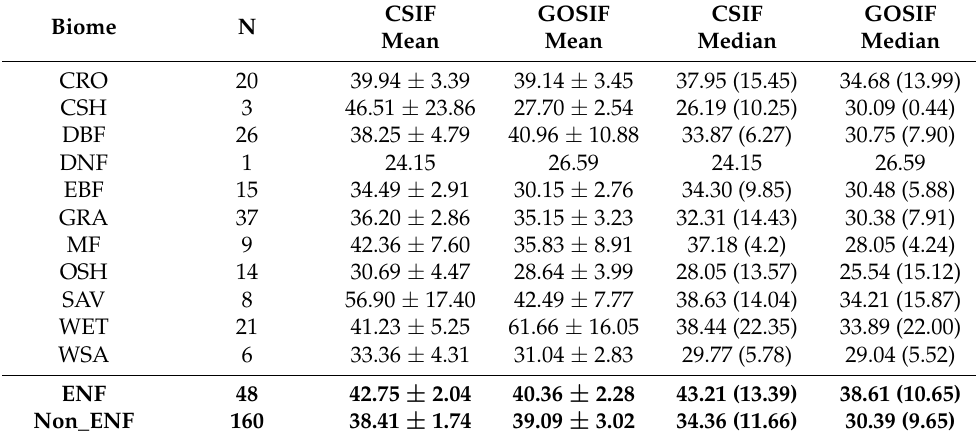
Table 1. Two-slope scheme of the linear SIFc–GPP relationship based on GPP/SIFc slopes at a site-multi-yearly scale. The SIFc dataset-dependent scheme divides all sites into two groups: ENF and non-ENF (11 biomes), according to the significance of the GPP/SIFc slopes (see Figure 3). All slopes are represented as mean ± SE or median (MAD). N is the number of sites included in the specific